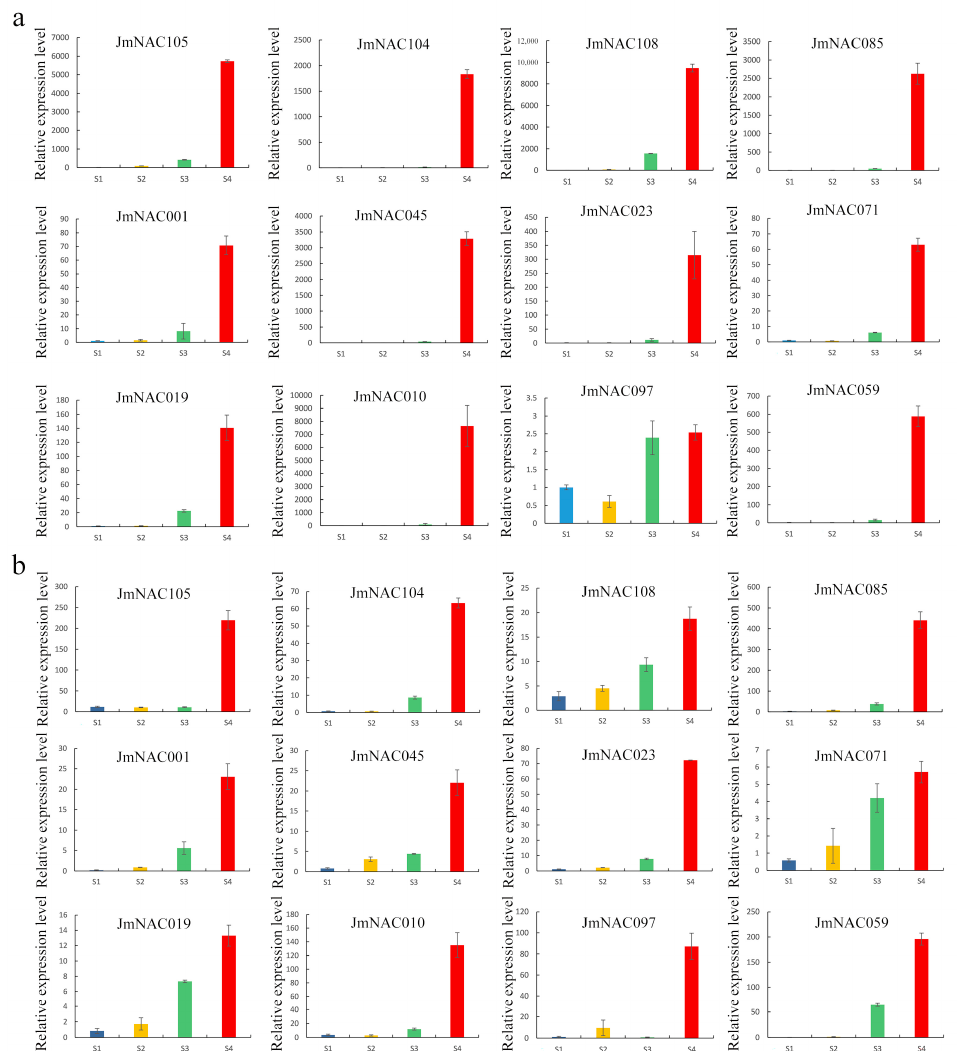
Figure 7. Expression profiles of 12 JmNAC genes during the development and ripening of fruits. ( a ) Relative expression of 12 JmNAC genes in walnut exocarp using RT-qPCR. ( b ) Relative expression of 12 JmNAC genes in walnut embryos using RT-qPCR. The y -axis shows the relative gene expression levels (2 − ∆∆ Ct ) analyzed by qRT-PCR. The x -axis represents the different tissue samples. The values are expressed as mean ± standard deviation of three replicates.